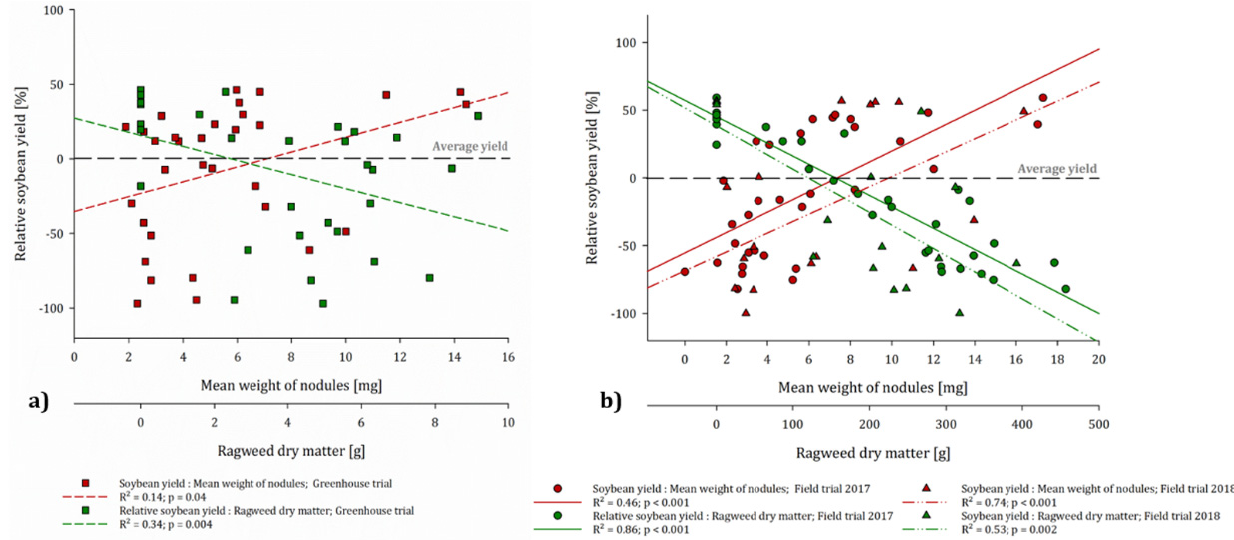
Figure 5. Regressions between the relative soybean yield in ( a ) greenhouse trials and ( b ) field trials (2017 and 2018), the mean weight of nodules (upper x -axis), and the amount of ragweed above ground dry matter present (lower x -axis; regression analysis, greenhouse trial: n = 32, field trial 2017: n = 32, field trial 2018: n = 16).